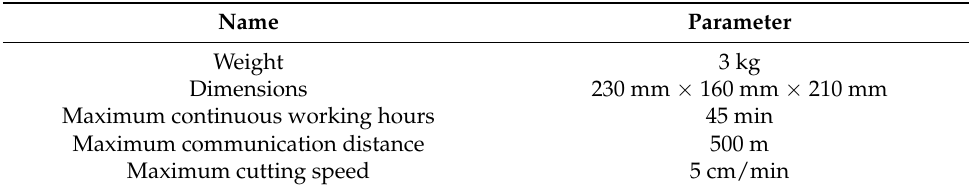
Table 1. Key parameters of the cable-stripping